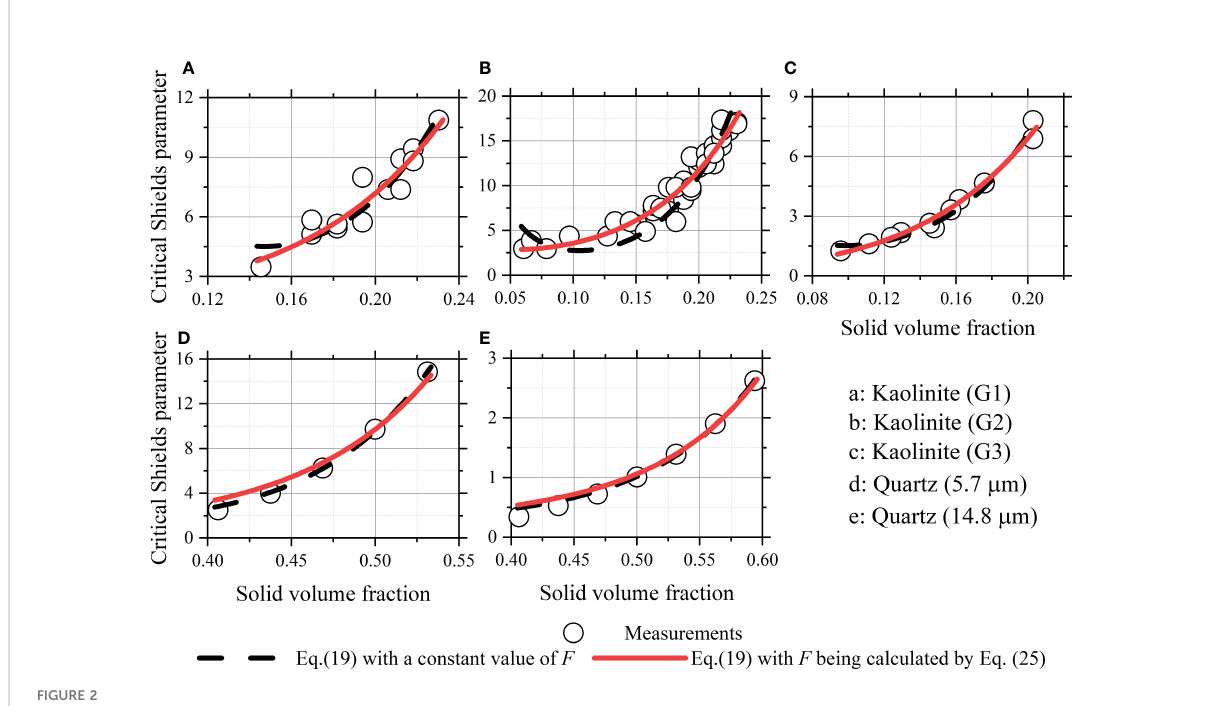
FIGURE 2 Applications of the developed formula in kaolinite and